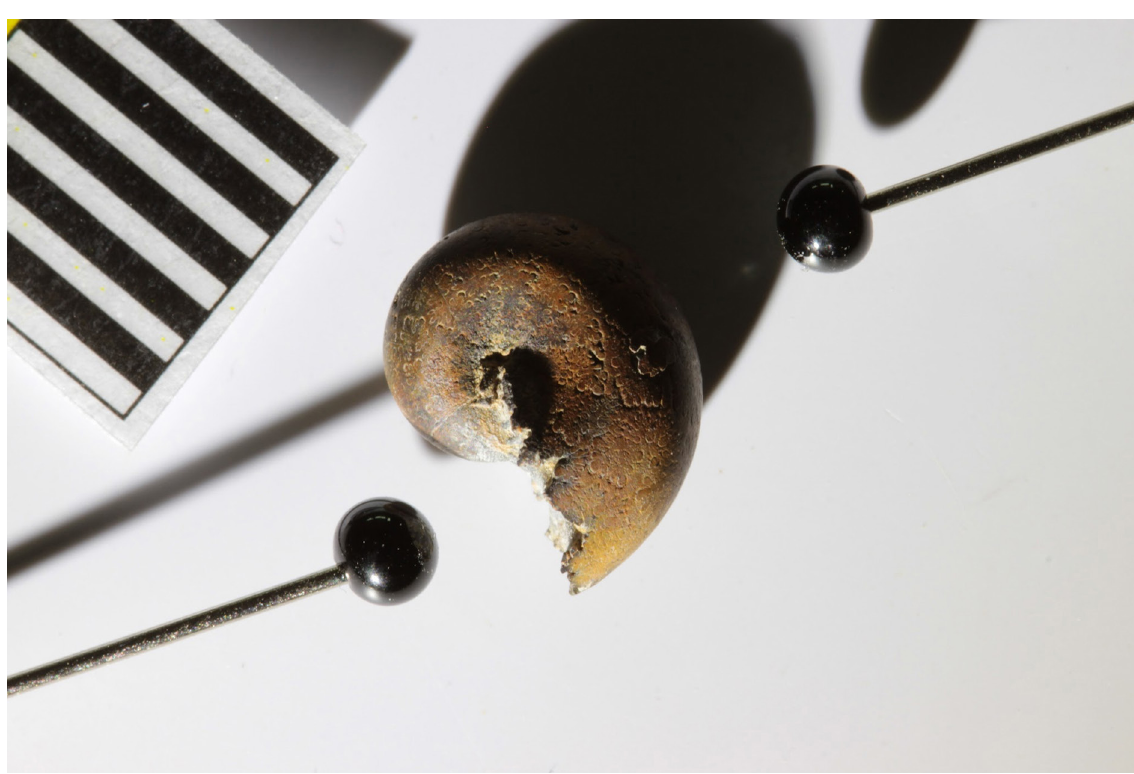
Fig. 2.28. Picture for H-RTI digitisation. The highlights on the black spheres allow the algorithm to reconstruct a RTI model.